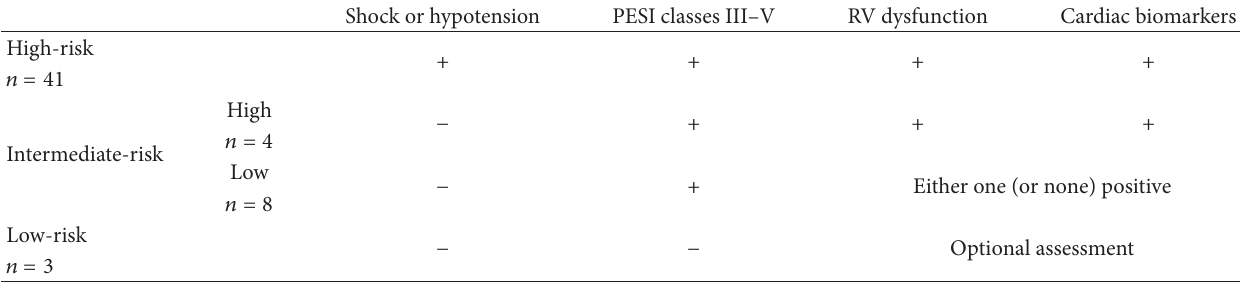
Table 2: Distribution of patients according to European Society of Cardiology risk class.